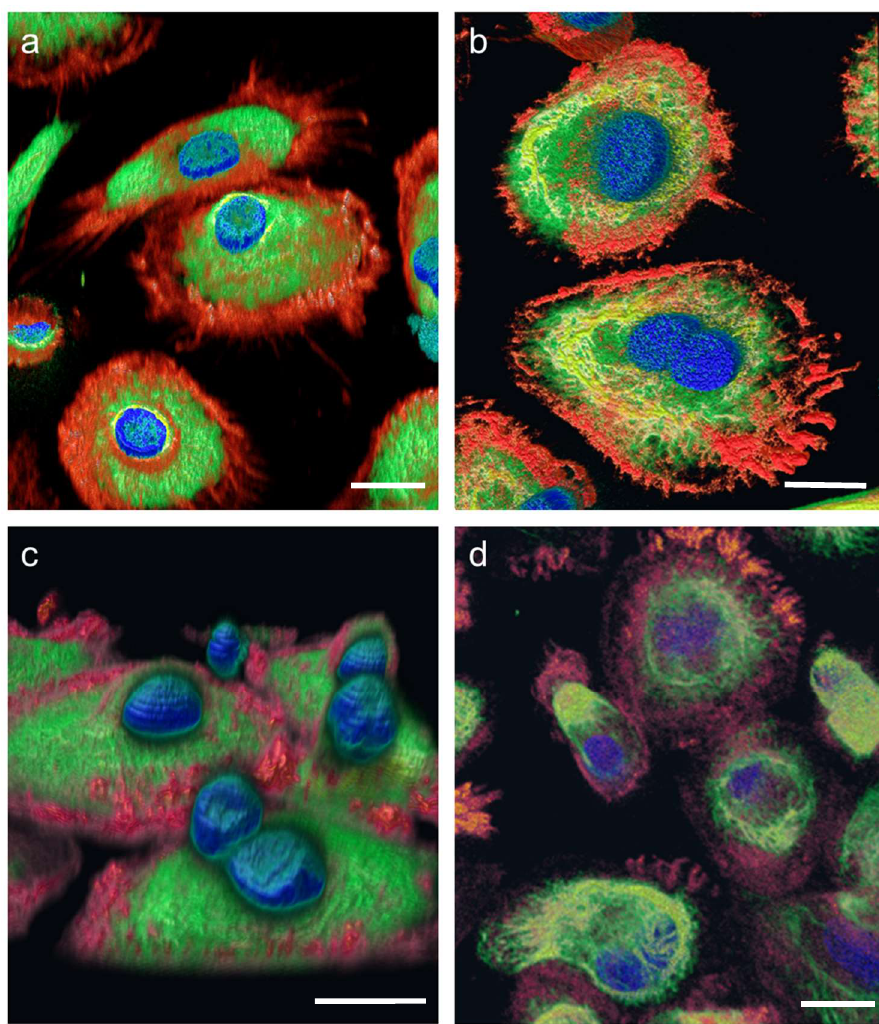
Figure 3. 3D-reconstructions of fixed primary human macrophages exposed to microgravity on the International Space Station (ISS). Cells were stained for nuclei (DAPI, blue), vimentin (anti-vimentin-Alexa Fluor 488; green) and actin (SiR-actin, red). Fluorescence microscopy images were acquired ( a ) on ground before upload to the ISS (Pre-flight ground control) ( b ) after 4 days of exposure to microgravity on the ISS (In-flight) and ( c ) on ground in parallel to the In-flight samples (Flight-parallel ground control). Additionally shown are ( d ) images from a pre-mission test of the FLUMIAS-DEA microscope (Independent pre-mission test). Image shown in ( c ) was acquired with a standard confocal microscope (Nikon A1R) while for ( a , b , d ) images were acquired with the FLUMIAS-DEA microscope. Images show the localization of cell structures in 3D. Note: Scale bars are 20 µm.